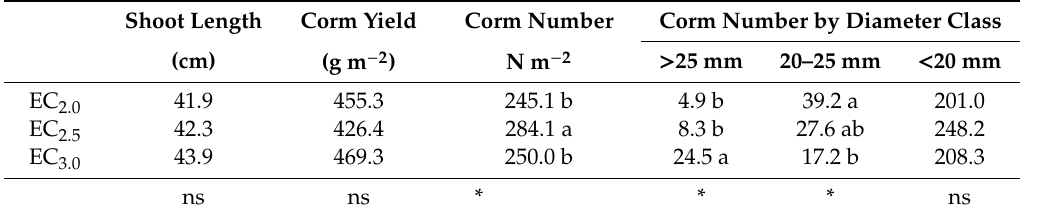
Table 1. Shoot length, corm yield, corm number and diameter-class distribution in soilless grown sa ff ron fertigated with nutrient solutions with electrical conductivity (EC) of 2.0 (EC 2.0 ), 2.5 (EC 2.5 ) and 3.0 (EC 3.0 ) dS · m − 1